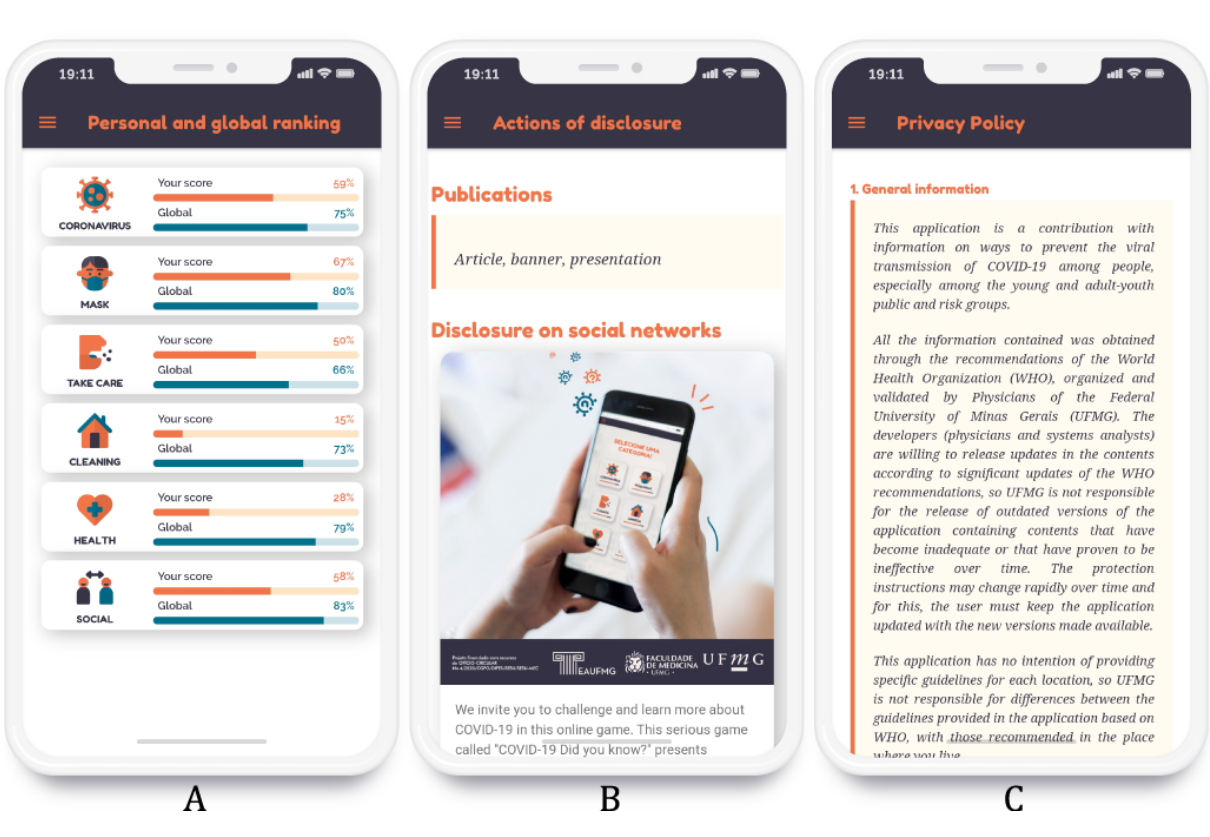
Figure 5. Personal and global ranking (A), disclosure actions (B), and Privacy Policy (C)